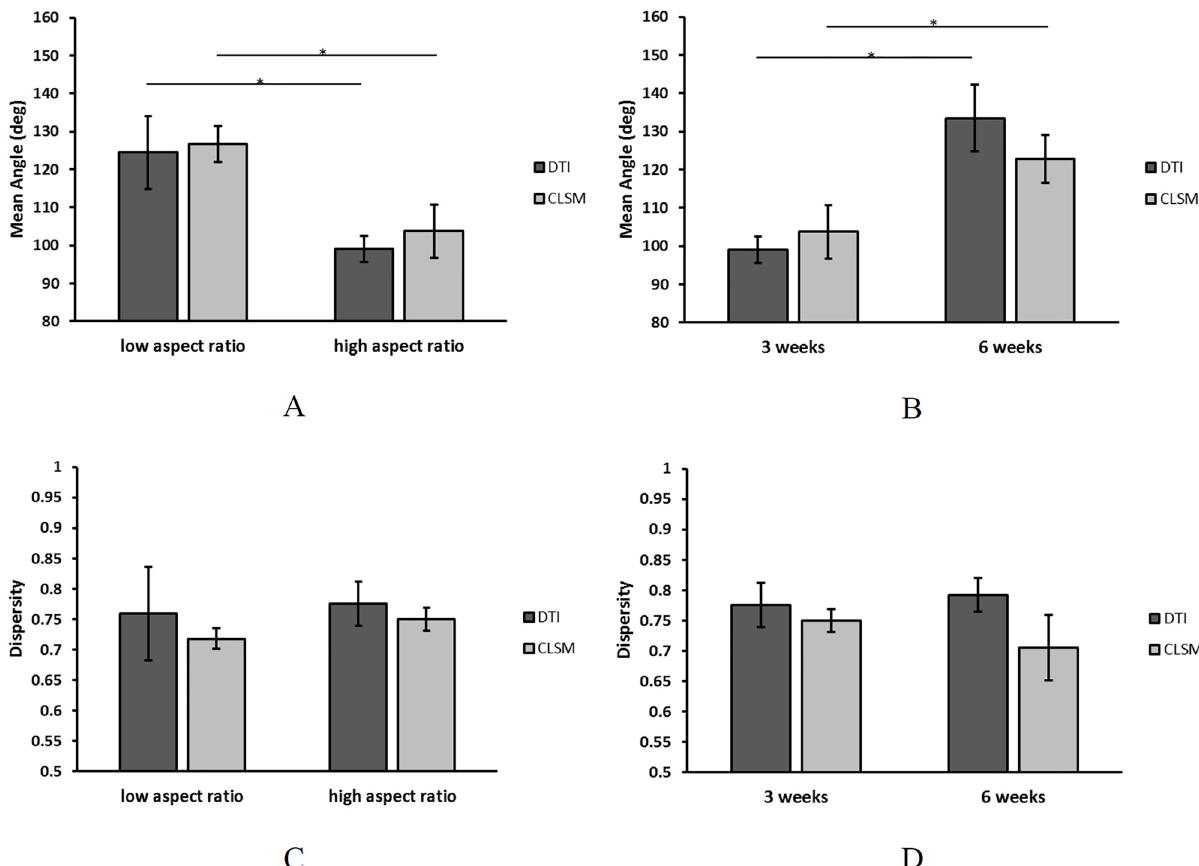
Fig 8. The mean angle and dispersity of fiber alignment of low aspect ratio and high aspect ratio constructs after 3 weeks of culture (A,C) and high aspect ratio after 3 and 6 weeks of culture (B,D). The mean angle of high aspect ratio group compared to low aspect ratio group and 6 weeks group compared to 3 weeks group was significantly changed. However, the dispersity was not significantly different between any of those groups. There was no significant difference between DTI and CLSM within any group. Each bar represents the mean ± SD ( * represents p <